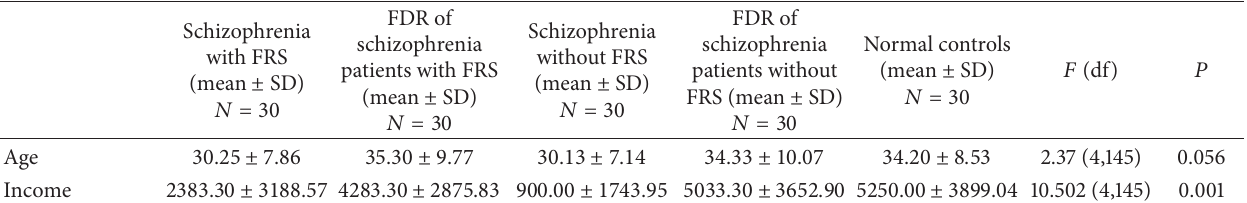
Table 1: Comparison of sociodemographic variables (continuous variable: age) between patients of schizophrenia with and without first rank symptoms (FRS), their first degree relatives (FDR), and normal